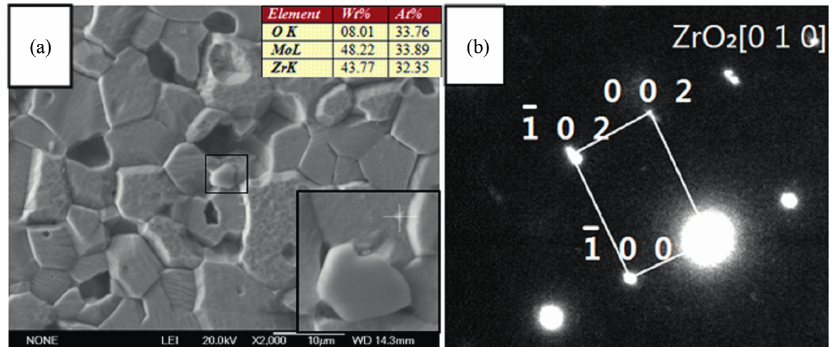
Figure 4: SEM image of Mo-0.1Zr and EDS patterns of the second